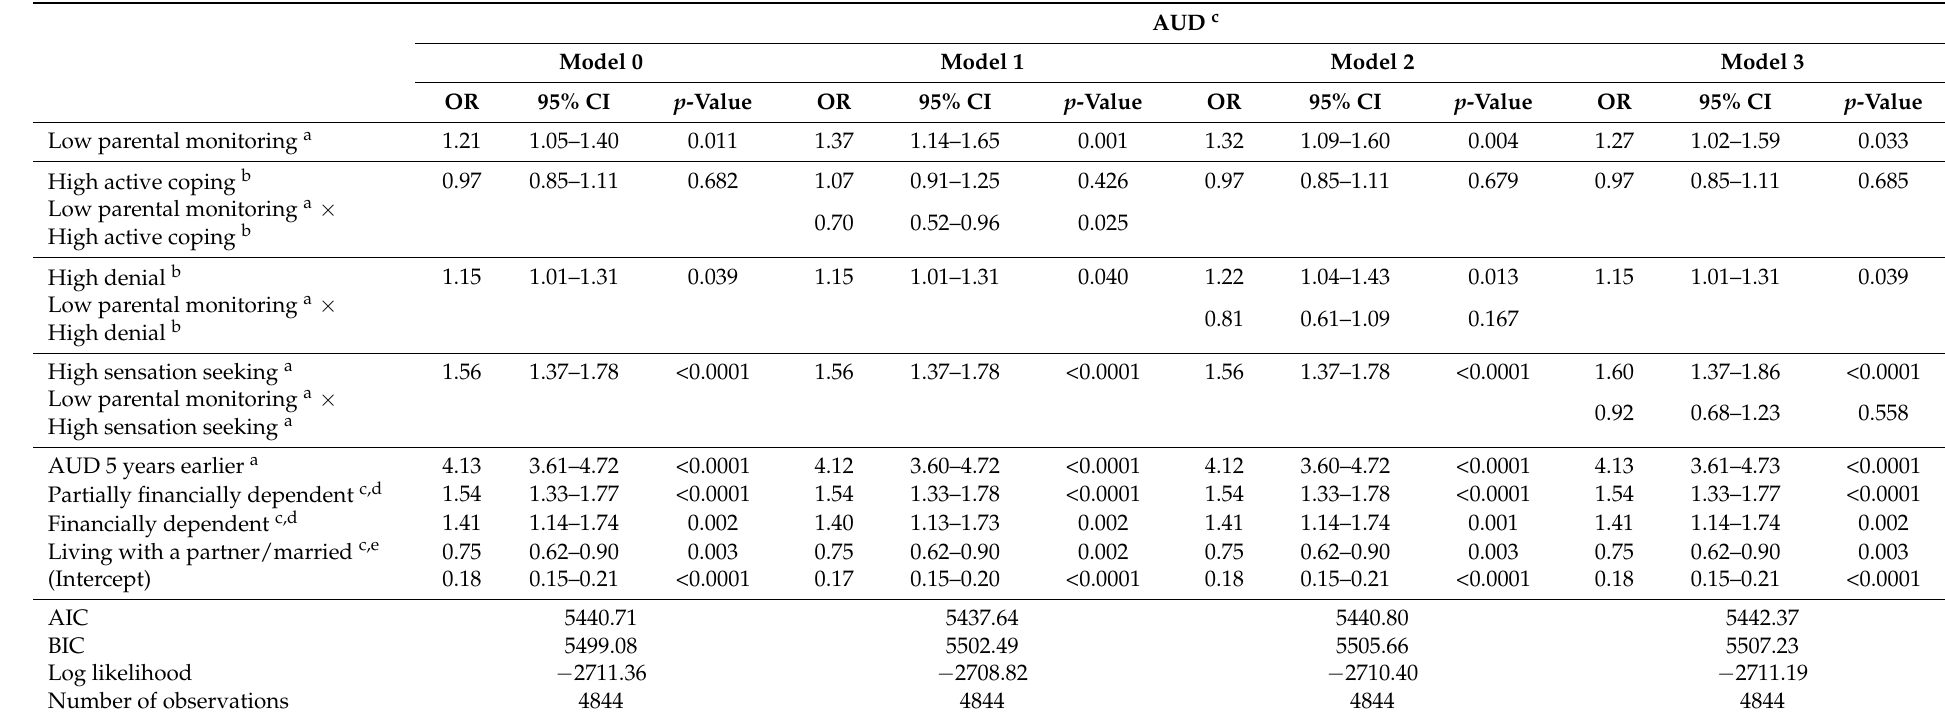
Table 2. Results of logistic regressions predicting alcohol use